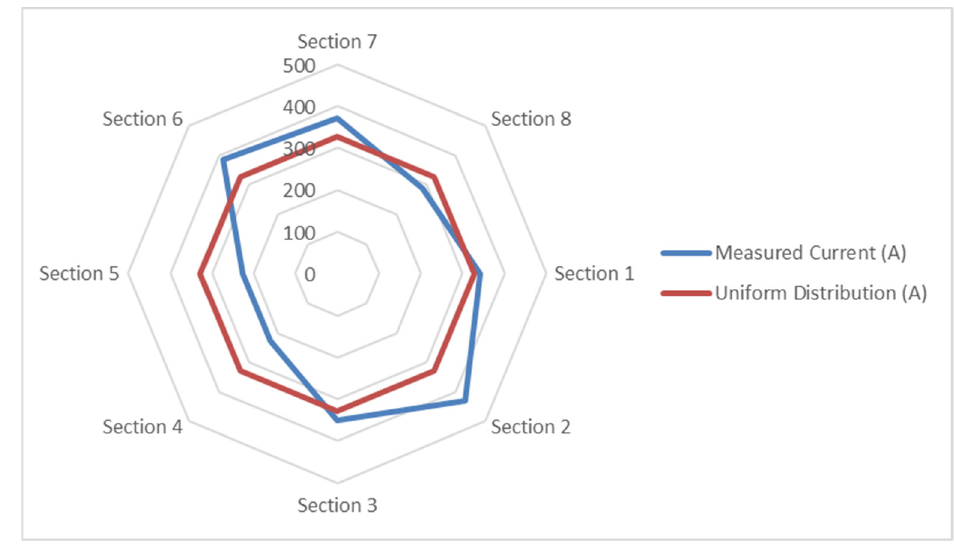
Figure 4. The measured distribution of the electrode current within the section feeders (blue line) and the desired uniform distribution (red line), with reference to the nominal current (2625 A).